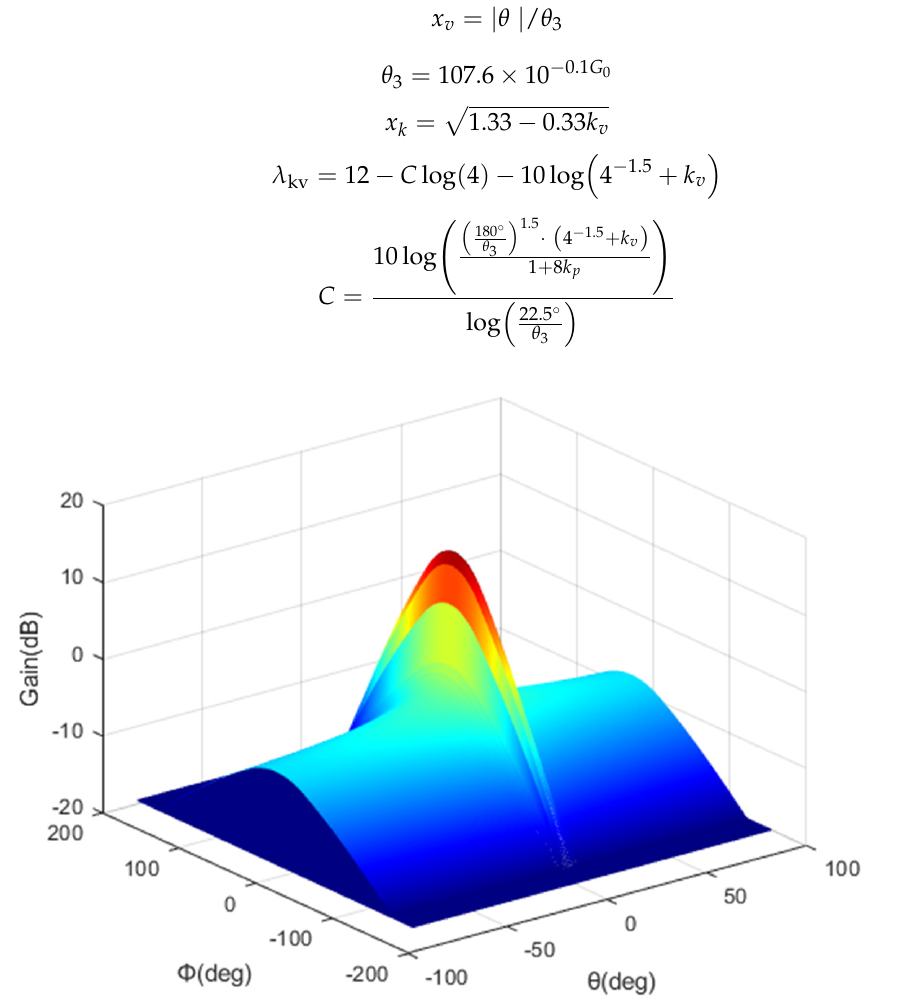
Figure 6. Interfered system antenna pattern.